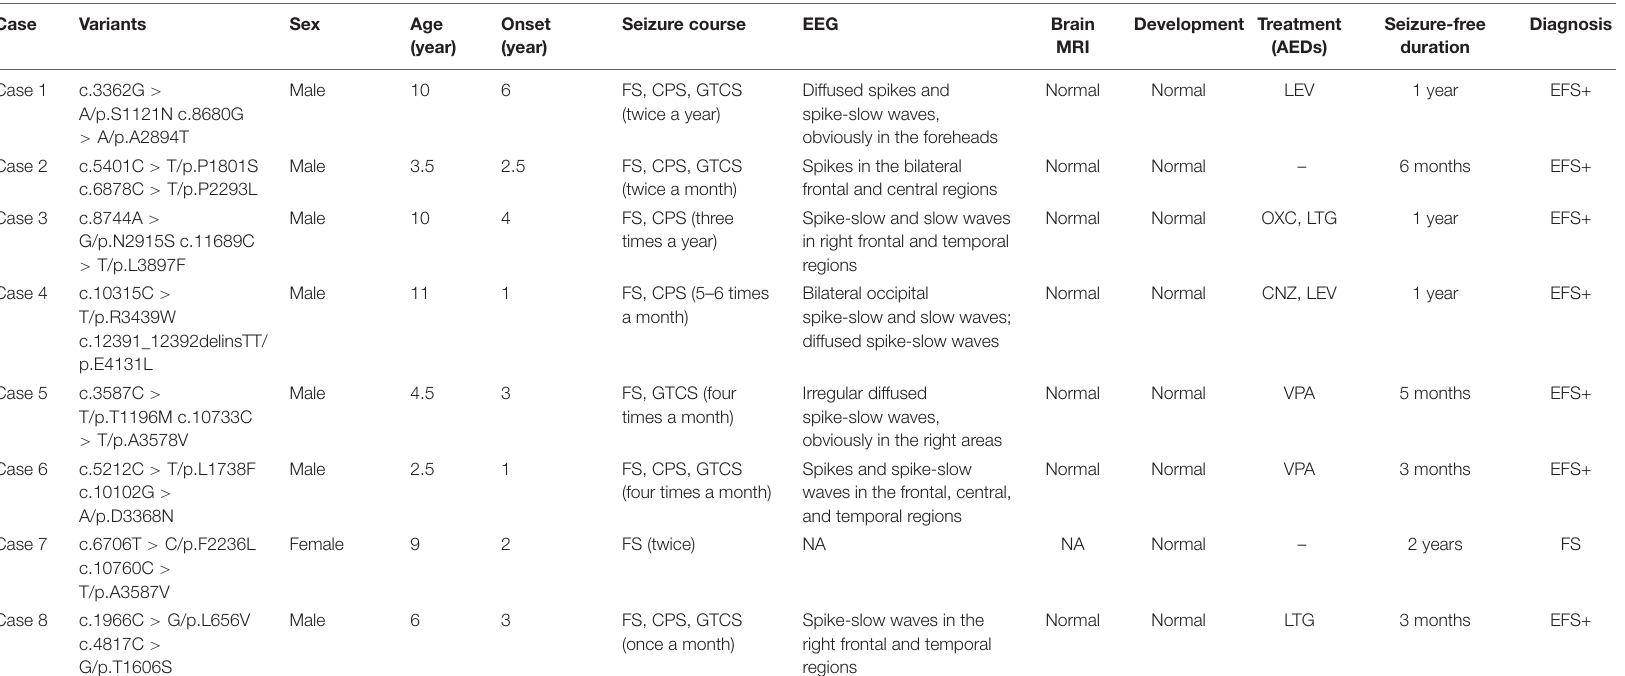
TABLE 1 | Clinical feature of the individuals with PKD1